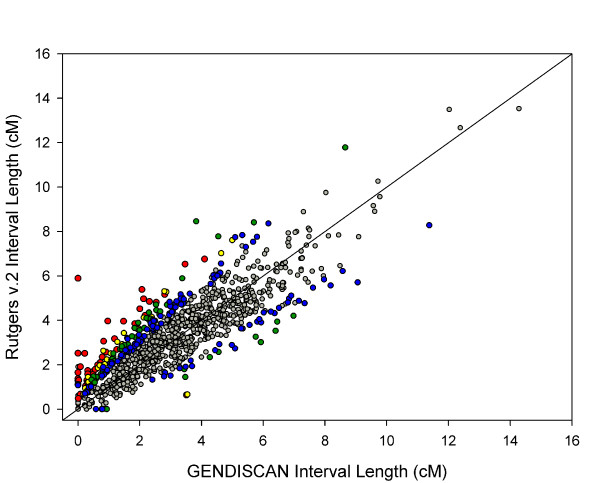
Comparison of genetic distances of 1017 marker intervals between the GENDISCAN map and Rutgers Map v.2. Color of dots represents the p-values for significances of genetic length differences between the GENDISCAN map and Rutgers Map v.2. Red, p < 0.0001; yellow, p < 0.001; green, p < 0.01; blue, p < 0.05 and gray, p > 0.05.